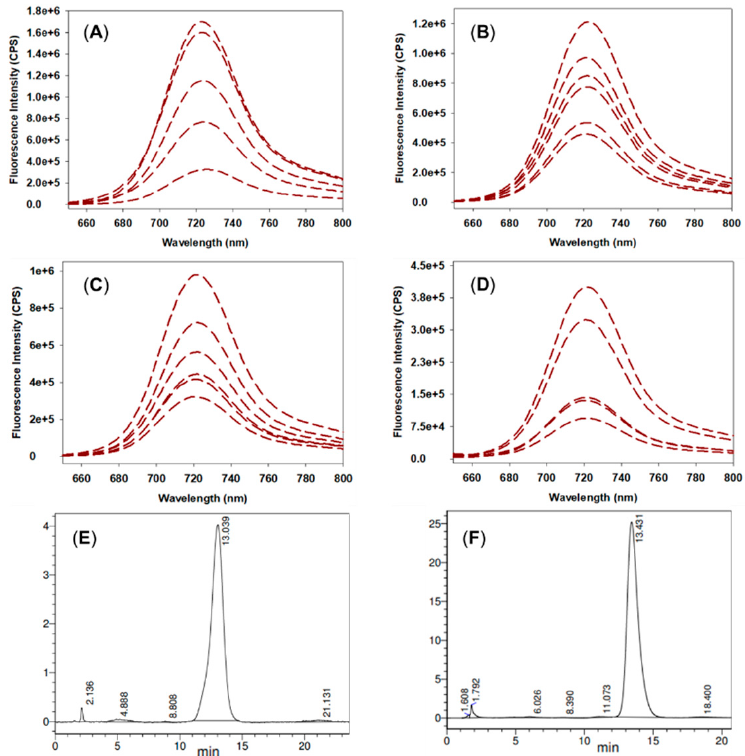
Figure 5. Fluorescence and HPLC analysis of rat urine samples. ( A ) Overlaid emission spectra of rat urine samples from 2.0 mg/kg dose. ( B ) 0.2 mg/kg dose. ( C ) 0.1 mg/kg dose. ( D ) 0.05 mg/kg dose. ( E ) Analytical HPLC of 12 ; CH 3 CN/H 2 O (45:55) as eluent, 650 nm detector, 1 mL/min flow rate. ( F ) Representative analytical HPLC of rat urine sample from 2.0 mg/kg dose with the same HPLC conditions as for ( E ).